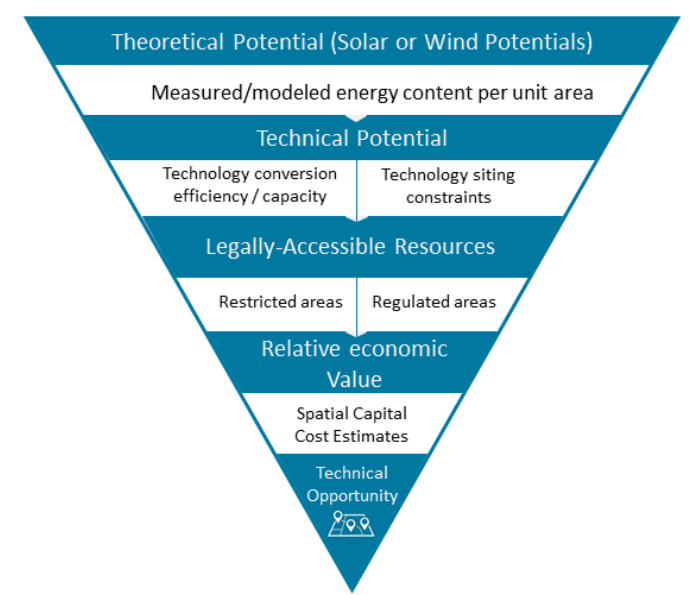
Figure 1. Town of Canmore. ISPRS Int. J. Geo-Inf. 2020 , 9 , x FOR PEER REVIEW